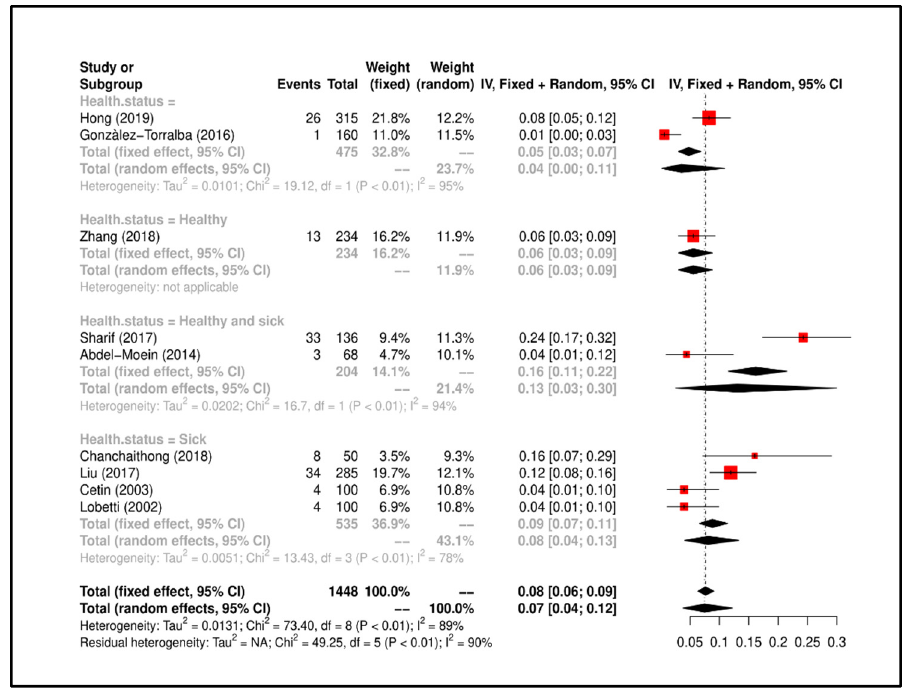
Figure 4. Forrest plot corresponding to occurrences of K. pneumoniae grouped by “health status of dog”.